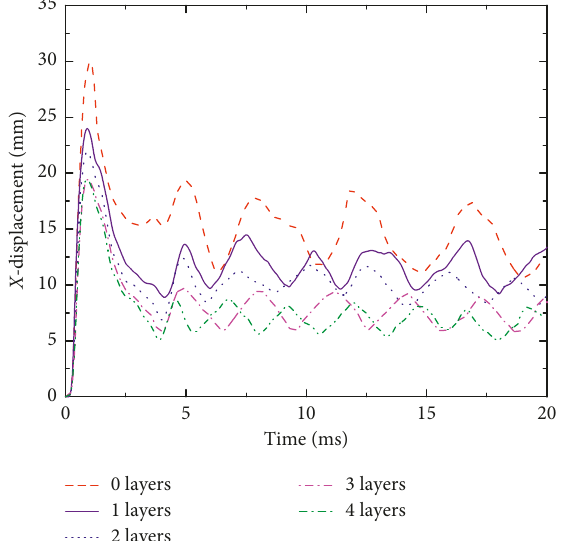
Figure 20: Comparison of midheight displacement with different thicknesses of FRP.